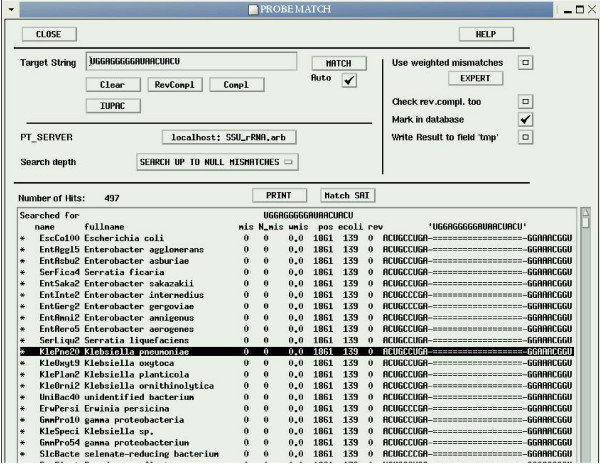
Probe match window. Probe Match Window showing results of in silico evaluation of the probe candidate (5'-UGGAGGGGGAUAACUACU-3') designed as part of a probe combination for the enterobacteria group. It hits 497 members of the group containing 947 species. Additional information such as number of mismatches, E. coli position, region up- and down-stream of the probe target in the actual nucleotide sequence along with the local alignment are also shown.